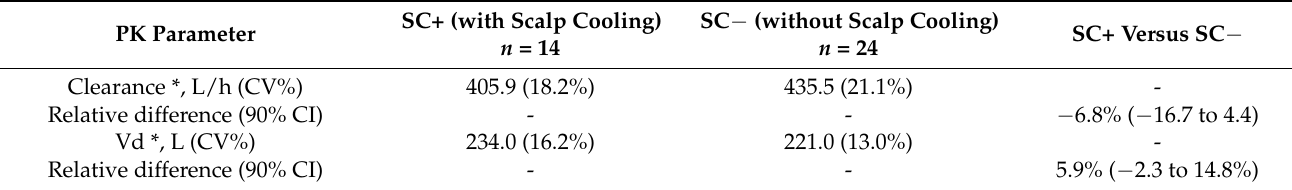
course of paclitaxel